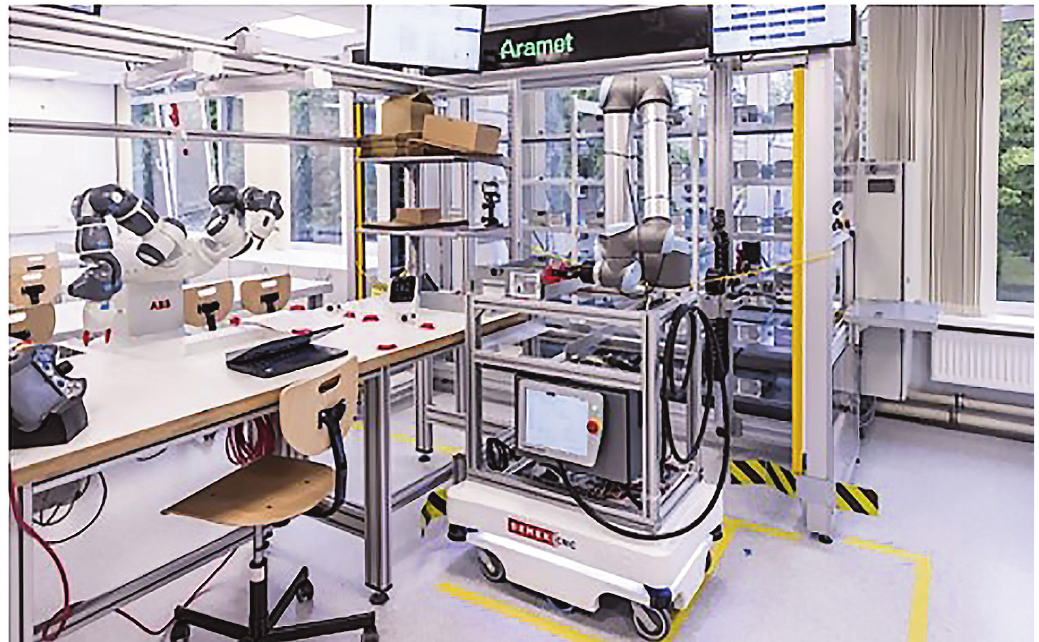
Fig. 1. Semi-industrial Industry 4.0 Lab with autonomous cobot